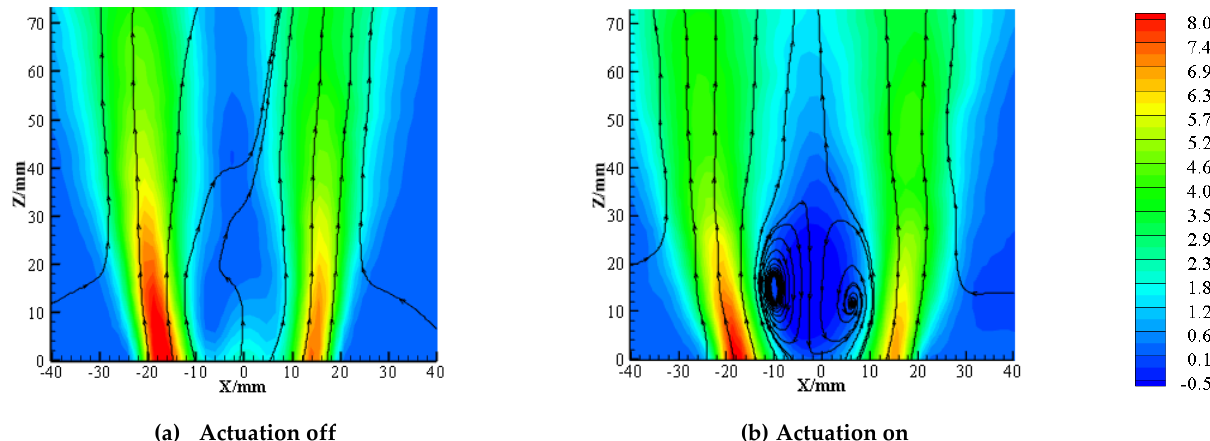
Figure 5. Contours of mean axial velocity magnitude and streamlinesin the XZ plane with bulk velocity of 5.7 m/s.